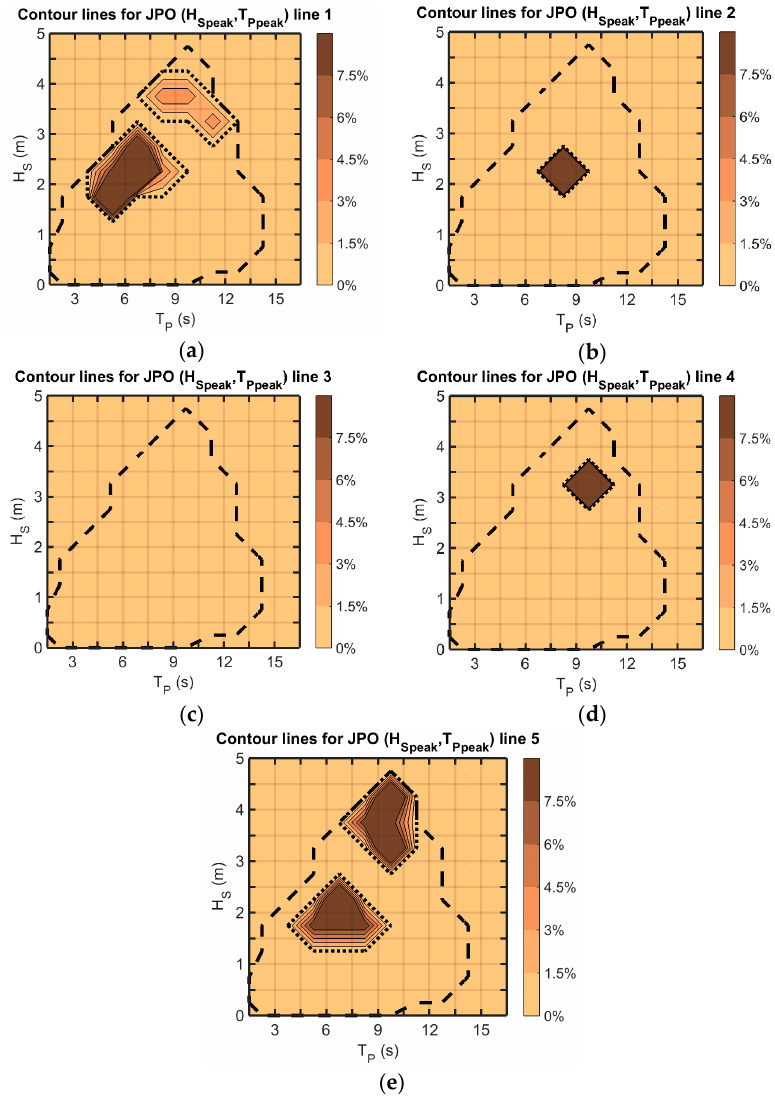
Figure 13. JPO for the Bolt ‐ 2 Lifesaver wave conditions associated with peak mooring loads: JPO ( H S peak , T P peak ) on mooring lines ( a ) 1, ( b ) 2, ( c ) 3, ( d ) 4 and ( e ) 5. The large black dashed line is the external contour line of the general environmental conditions. The thin black dotted line is the external contour line of the environmental conditions associated with peak mooring load.